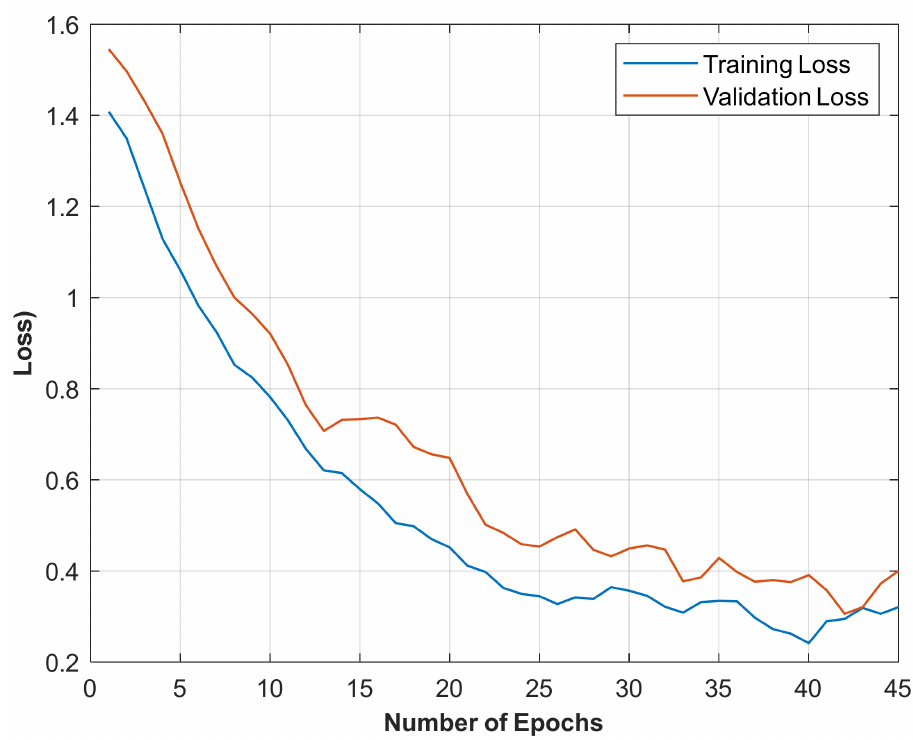
Figure 7. Training loss and validation loss of the nested-CNN. The nested-CNN’s performance was evaluated with six desired reflection coefficients. Desired reflection coefficient maximum value was chosen as − 5 dB, the minimum value was chosen lower than − 40 dB, the minimum bandwidth was chosen as 0.75 GHz. In Figure 8, the desired reflection coefficients, the image of MM—which is gradient-based generated by nested-CNN—and the simulation results of the image of MM are